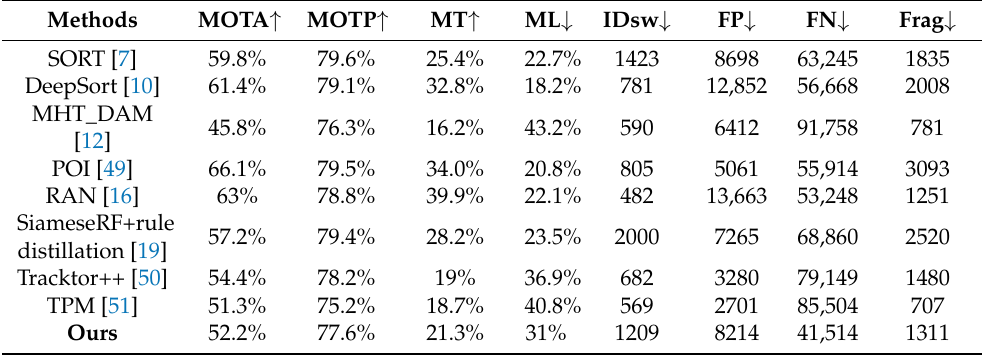
Table 4. Multitarget tracking evaluation list. “ ↑ ”: higher scores denote better performance, “ ↓ ”: lower scores denote better